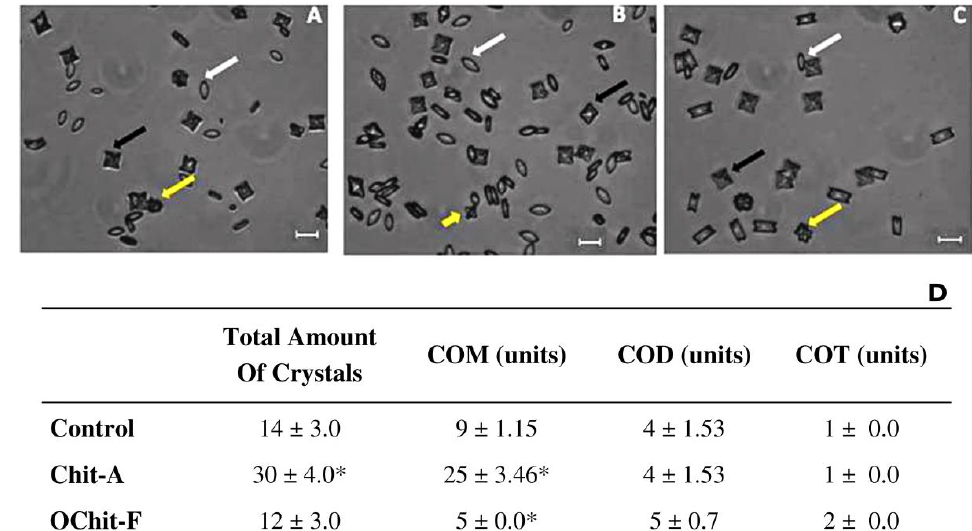
Figure 4. Images of different types of CaOx crystals formed under different conditions. Crystal formation in ( A ) control; ( B ) animal chitosan solution; ( C ) fungal oligochitosan solution. ( D ) Average number of the three types of calcium oxalate crystals, COM, COD, and COT, formed. White arrows (COM crystals), black arrows (COD crystals), and yellow arrows (COT crystals). * Indicates a significant difference ( p < 0.05) between the crystals formed in the absence (Control CaOx) and presence of samples. The bars correspond to 10 µ m. The images were obtained with a brightfield microscope as described in Methods Section.